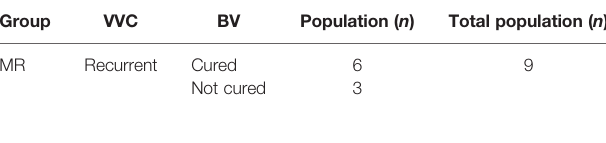
TABLE 2 | Speci fi c information of the study population with recurrences. Group